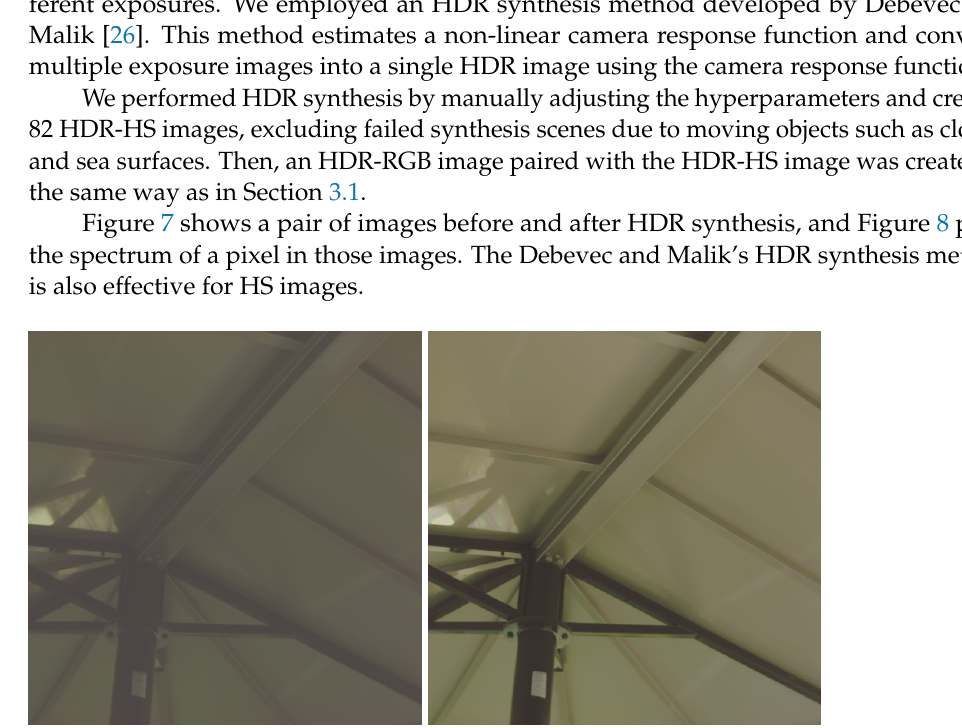
Figure 7. Comparison of LDR and HDR images. The left is LDR-HS, and the right is HDR-HS image.